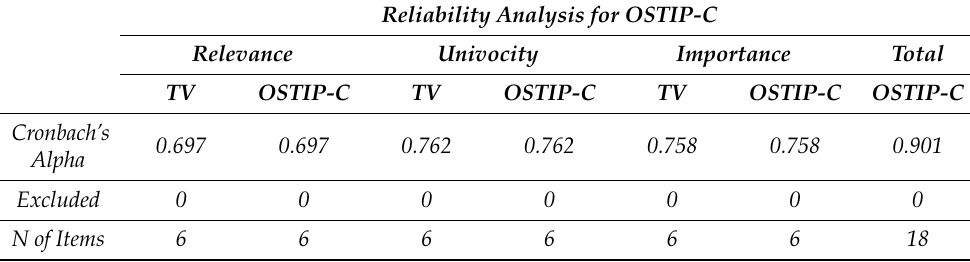
Table 8. Reliability analysis for the OSTIP-C